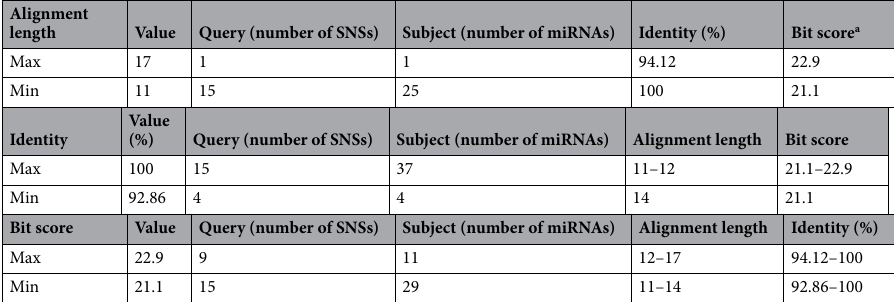
Table 6. Summary of the similarity between 16 SNS and miRBase miRNAs. a A high bit score indicates a better alignment.